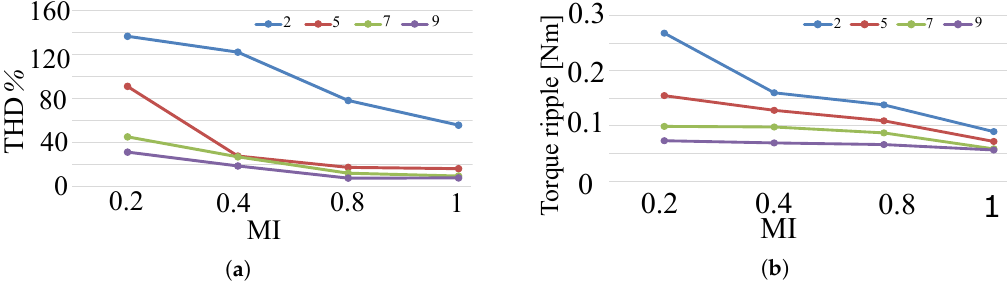
Figure 9. Comparison between 2, 5, 7 and 9-level inverter configurations: ( a ) total harmonic distortion (THD)%. ( b ) Torque